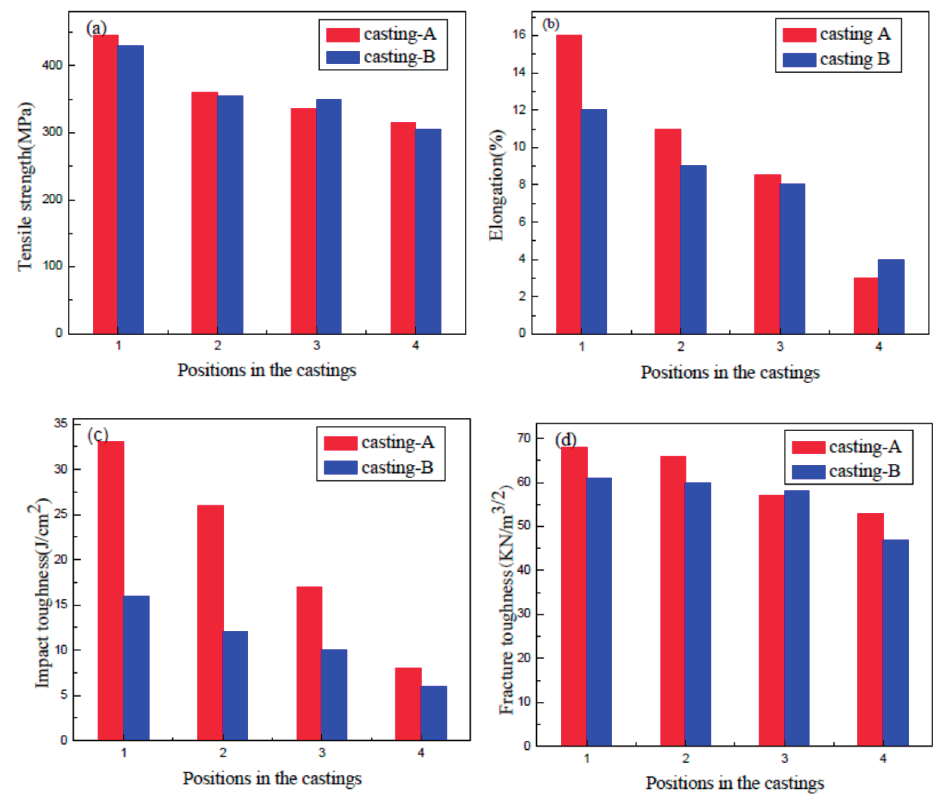
Figure 6. The tensile strength, elongation, impact toughness and fracture toughness at four positions of two castings ( a ) Tensile strength; ( b ) Elongation; ( c ) Impact toughness; and ( d ) Fracture